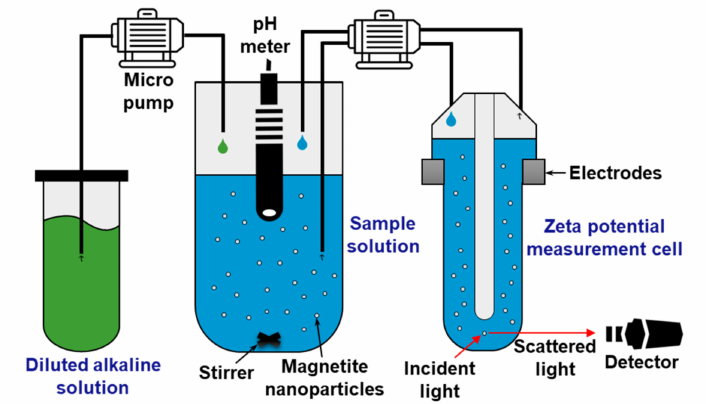
Figure 1. Schematic of zeta potential measurement setup using an automatic pH titration system.